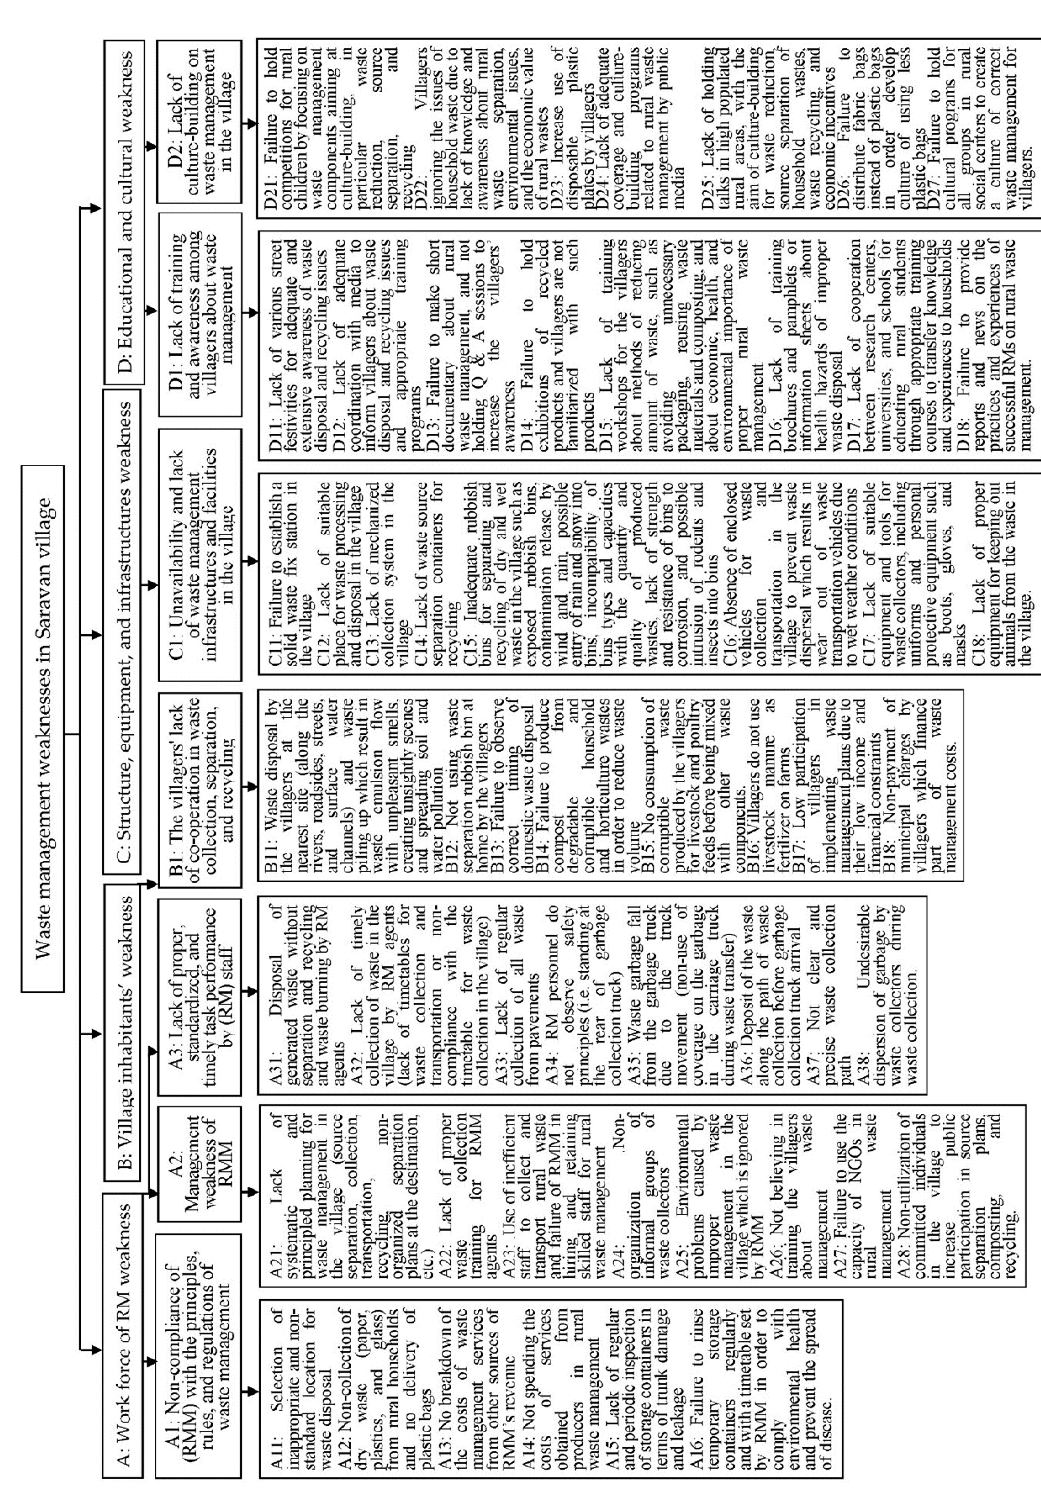
Fig. 2: Hierarchical decision